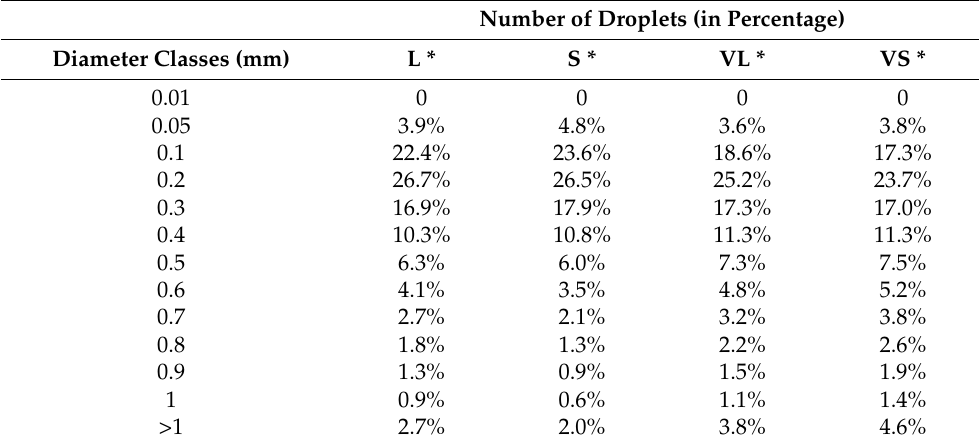
Table 6. Summary table about the number of droplets per diameter range, expressed in